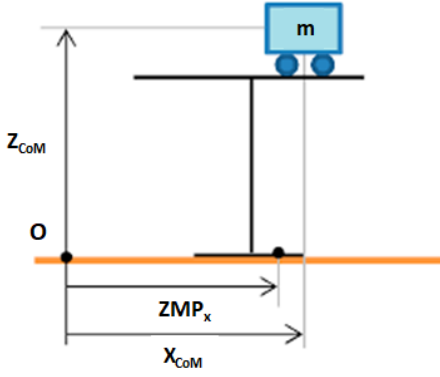
Figure 5. The cart-table simplified model. ZMP: zero moment point.